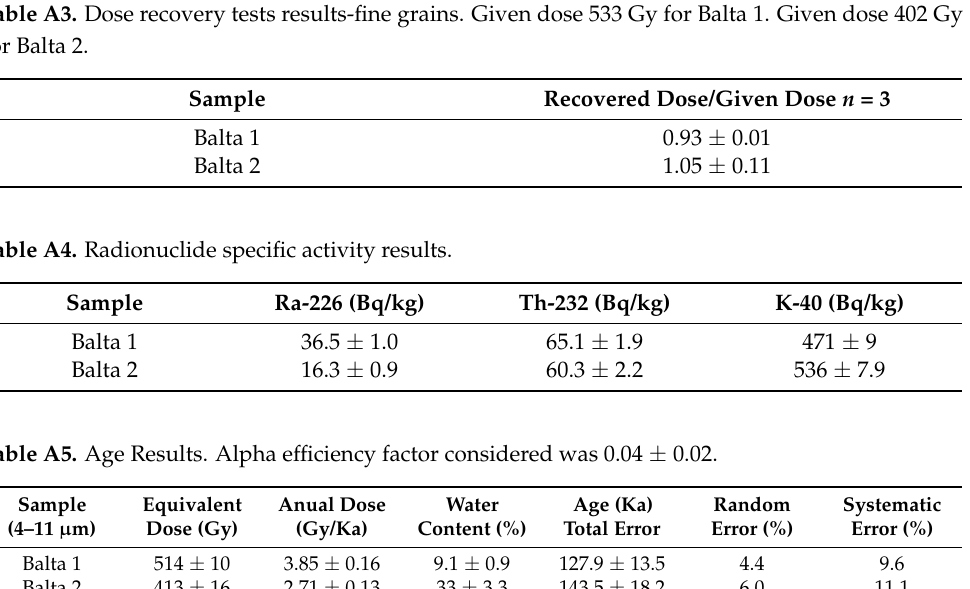
The uncertainties mentioned with luminescence and data are random errors; the uncertainties mentioned with the optical ages are the overall uncertainties. All uncertainties represent 1 σ (63% confidence